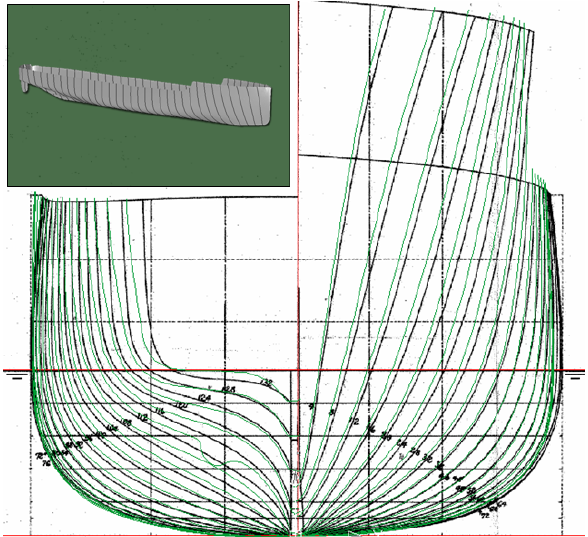
Figure 5: 2D comparison between cross sections of the scanned model and the original lines